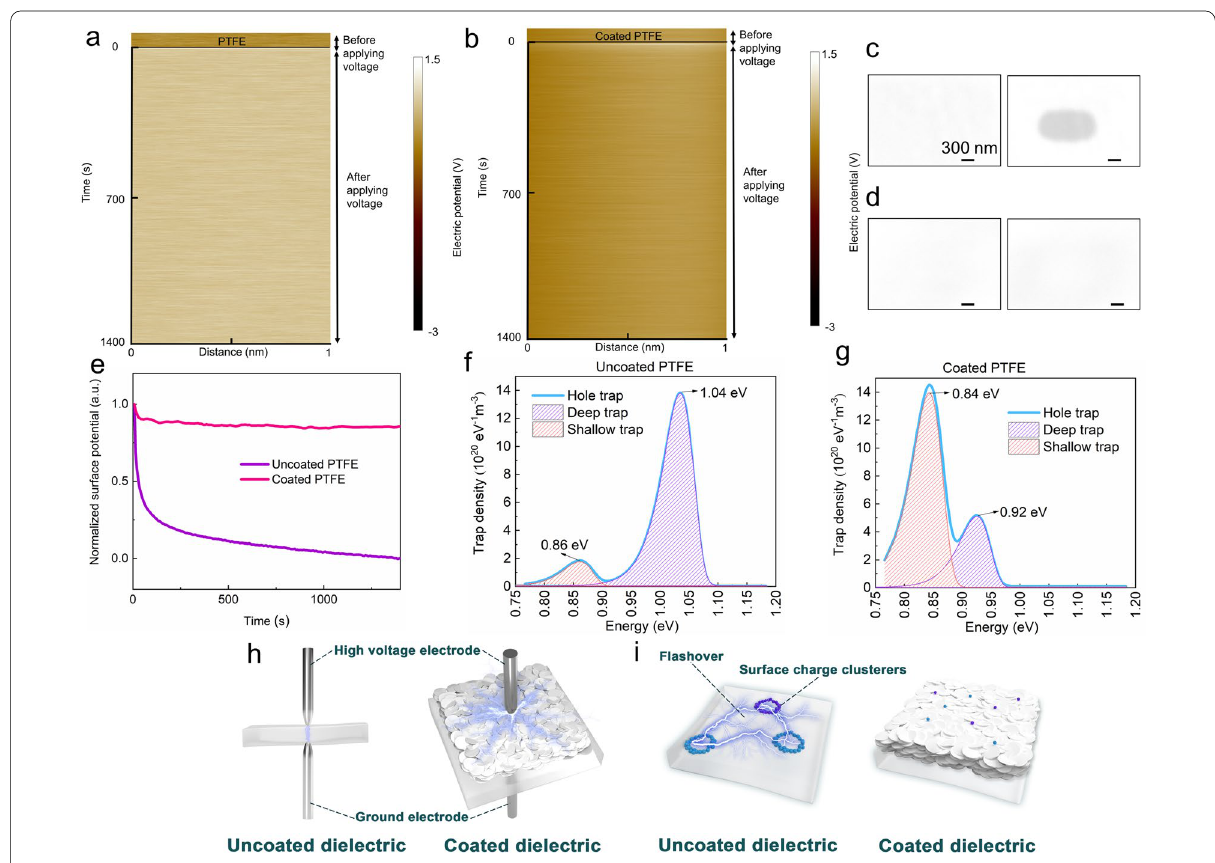
Fig. 3 Charge characteristics of nanodomains, trap parameters, and schematic diagram of the coating to enhance the electrical strength of polymer dielectrics. a Surface potential dissipation map of PTFE based on KPFM. b Surface potential dissipation map of coated PTFE based on KPFM. c Images of PTFE before (left) and after (right) charging by SEM. d Images of coated PTFE before (left) and after (right) charging by SEM. e Normalized surface potential dissipation curves of PTFE before and after coating. f PTFE trap parameters, g Coated PTFE trap parameters. h Schematic diagram of the mechanism by which the coating enhances the breakdown strength. i Schematic diagram of the coating to enhance the flashover